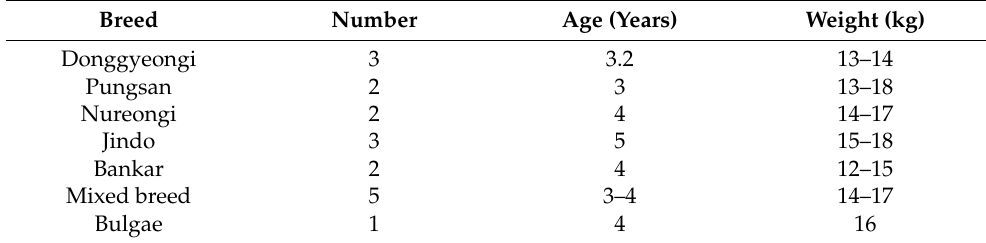
Table 2. List of house dogs that participated in this